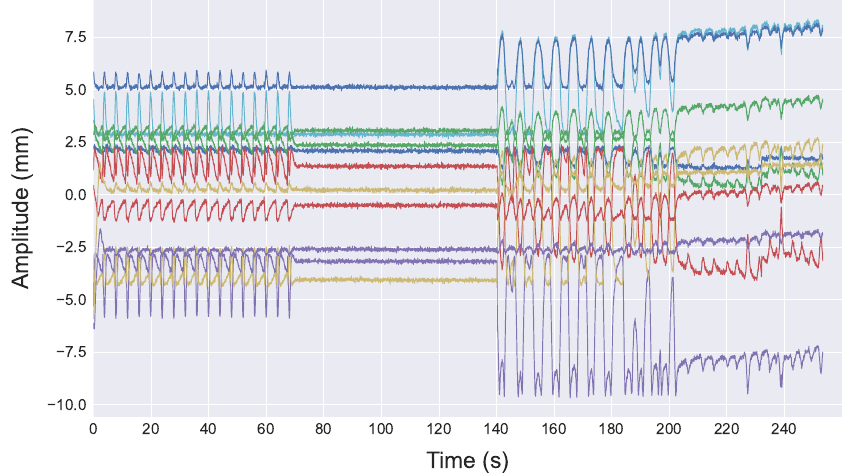
Figure 5. Raw radar signals from 11 consecutive range bins (distance from radar) covering an area in the vicinity of the target breathing signal from the RMP. Each line represents the signal from one of the 11 range